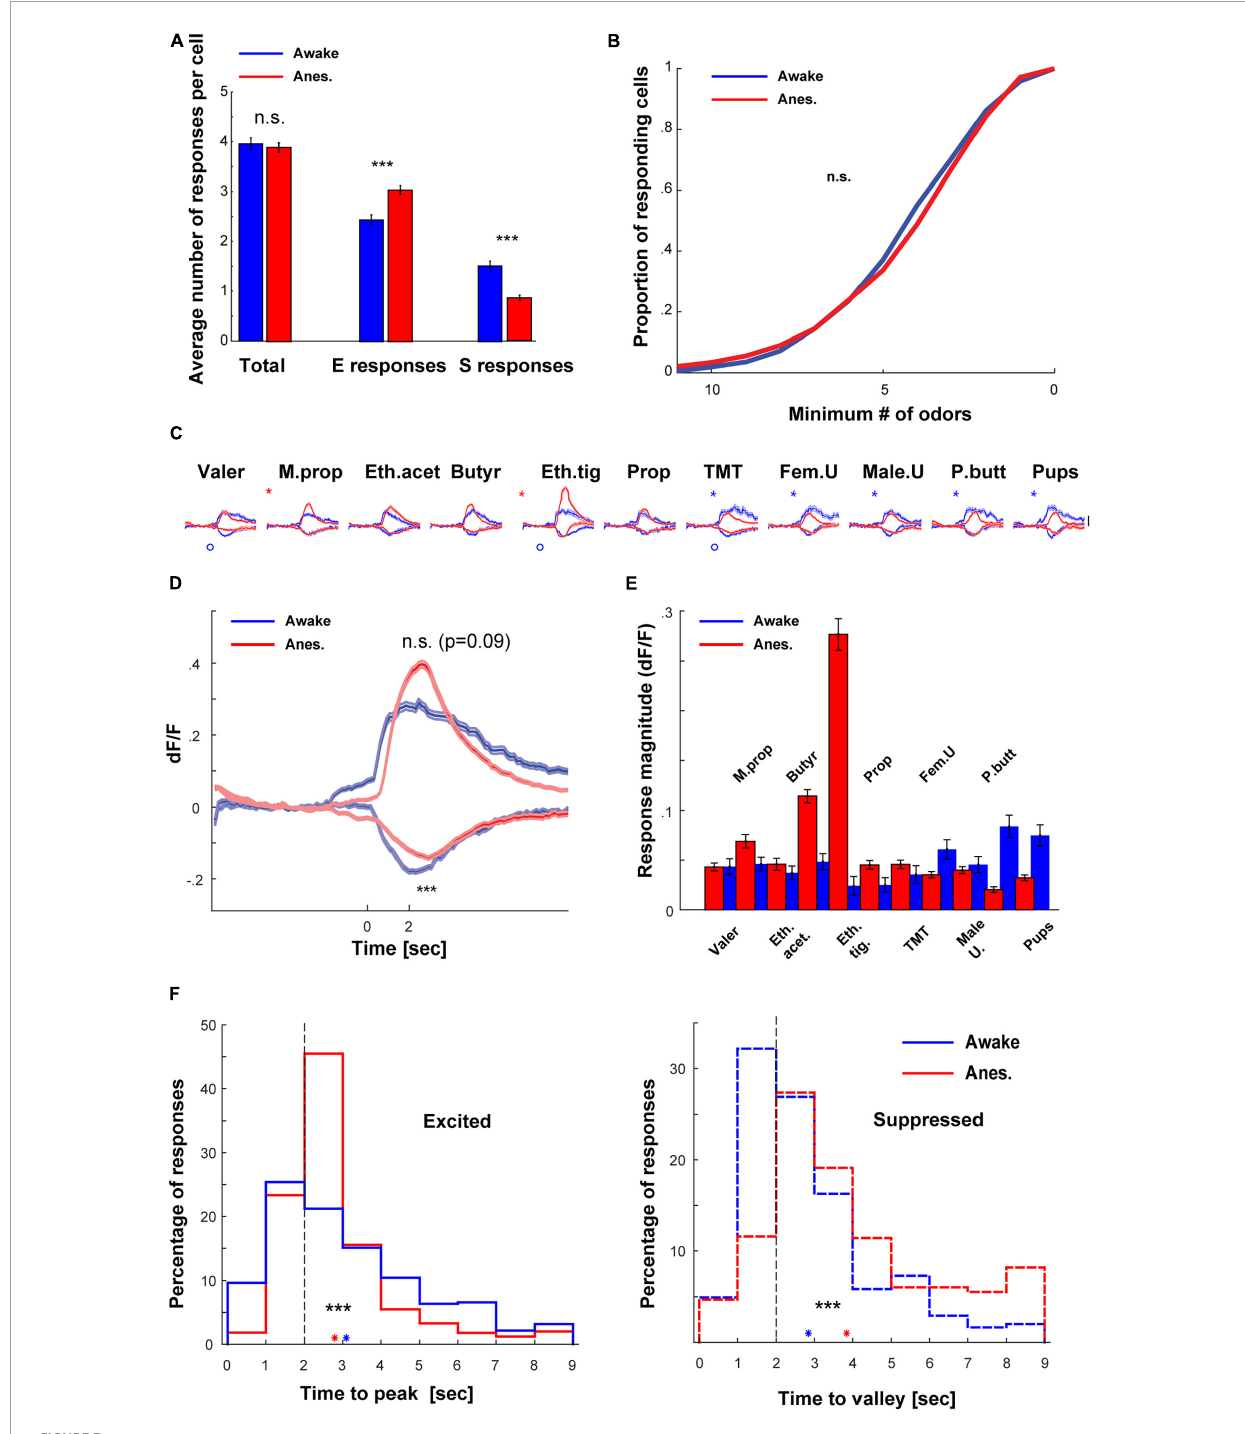
FIGURE3 Comparison of the awake vs. anesthetized datasets. (A) Bar graphs summarizing the differences in number of responses per cell between awake and anesthetized mice. (B) Cumulative distribution of the proportion of mitral cells (MCs) responding to 0–11 odors, in wakefulness (blue) and anesthesia (red). MCs responsiveness profile was not different between awake and anesthetized mice ( p = 0.063, Two-sample Kolmogorov–Smirnov test). (C) Average traces of S and E responses per each one of the odors presented to awake (blue) and anesthetized (red) mice (mean ± SEM). Scale – vertical black line, 20% dF/F. Asterisks denote differences in the E responses and circles in S responses. (D) Traces of S and E responses averaged across all odors presented to awake and anesthetized mice (mean ± SEM). (E) Mean dF/F values, averaged throughout the response window over all cells included in the datasets of both awake and anesthetized mice. (F) Left- histograms depicting times to reach maximum value for E responses in wakefulness ( n = 882 responses, N = 11 mice) and under anesthesia ( n = 2130, N = 20 mice) mice. Responses in anesthetized mice peaked significantly earlier. Right- histograms depicting times to reach minimum value for S responses in awake ( n = 547 responses) and anesthetized ( n = 596 responses) mice. Responses in awake mice reached minimum value significantly earlier. Blue and red asterisks denote the mean time to extremum for responses recorded in awake and anesthetized mice,